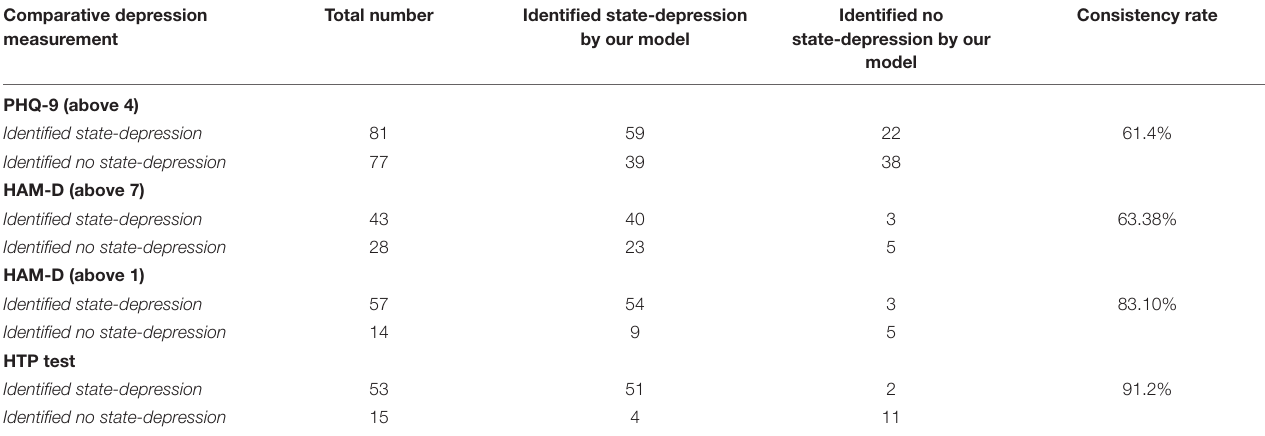
TABLE 1 | Comparison of results between our model and PHQ-9, HAM-D, HTP, respectively. Comparative depression measurement